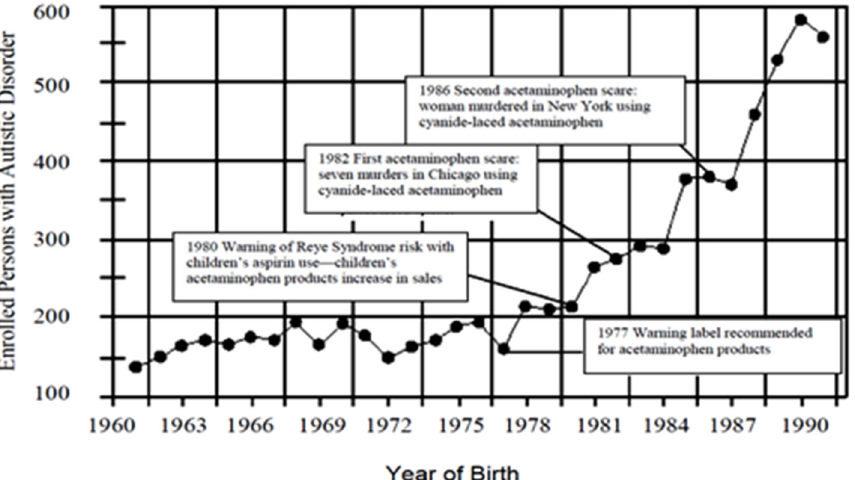
Figure 7. The number of persons with ASD by year of birth in California which was published by the state Department of Developmental Disabilities. Reprinted from [27], with permission from Elsevier (license #5034221427131).